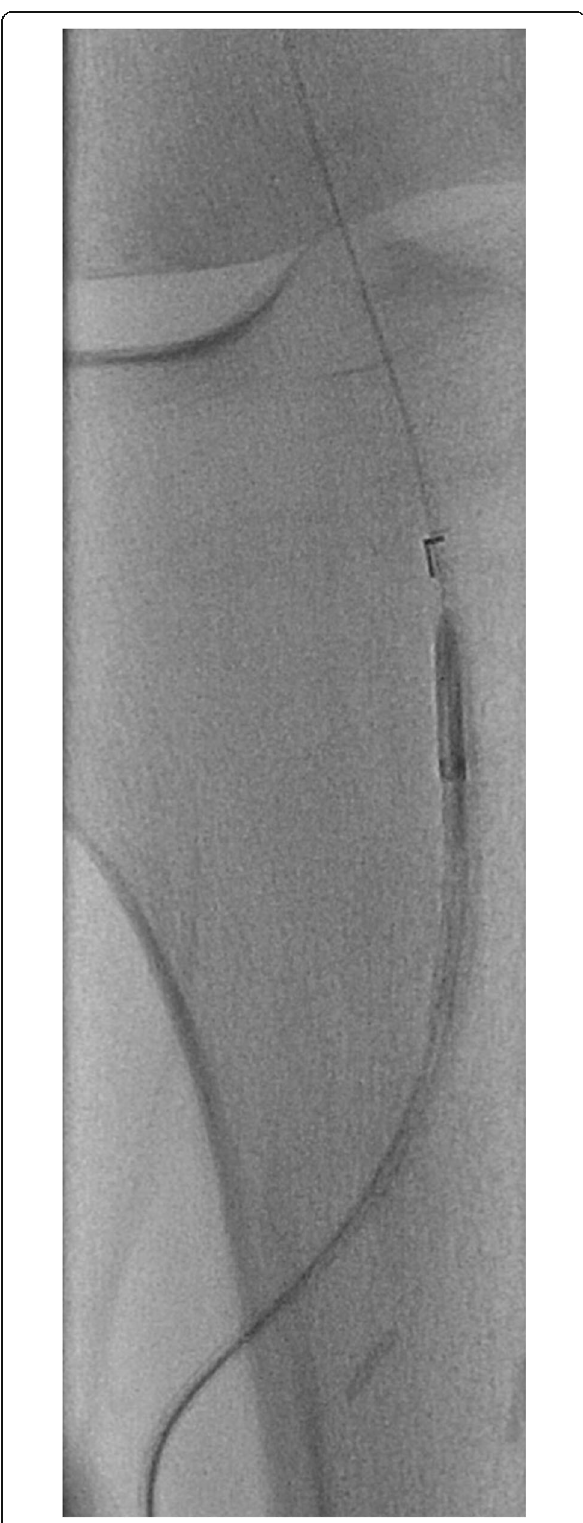
Fig. 3 Outback catheter re-entry device inserted sheath less from the anterior tibial artery access over an 0.18 wire